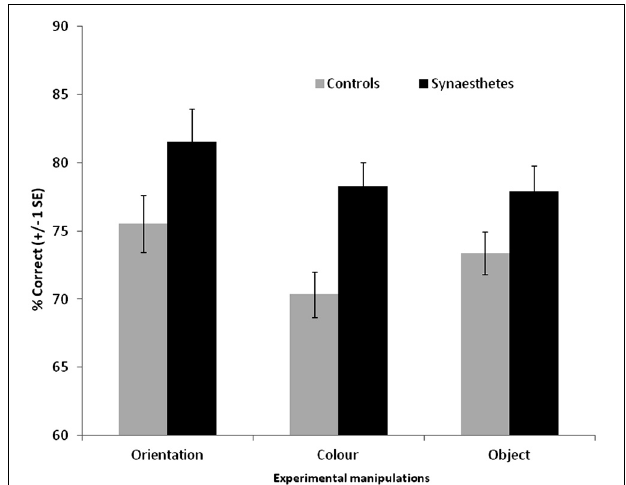
FIGURE 5 | Recognition memory accuracy (% correct) for grapheme-color synaesthetes and controls for different manipulations of scene images. Error bars show ± 1